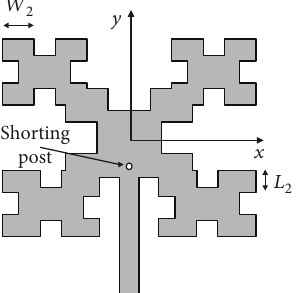
Figure 2: Microstrip patch antenna with Koch fractal contour of level k = 2 and the shorting